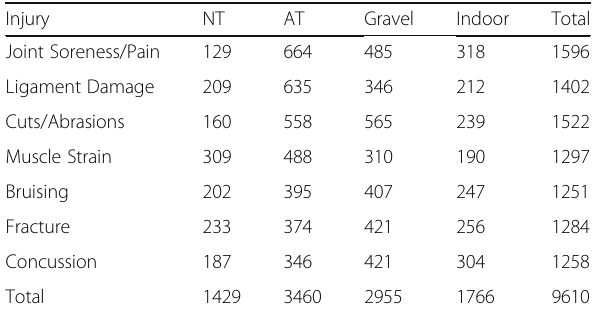
Table 2 Contingency table of type of injury associated with Natural Turf (NT), Artificial Turf (AT), Gravel or Indoor playing surfaces Injury NT AT